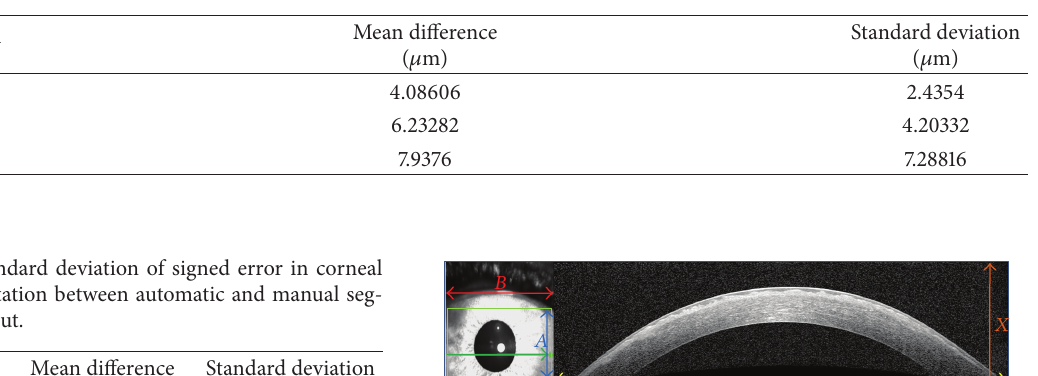
Table 5: Mean and standard deviation of unsigned error in corneal layer boundary segmentation between automatic and manual segmentation using graph cut.